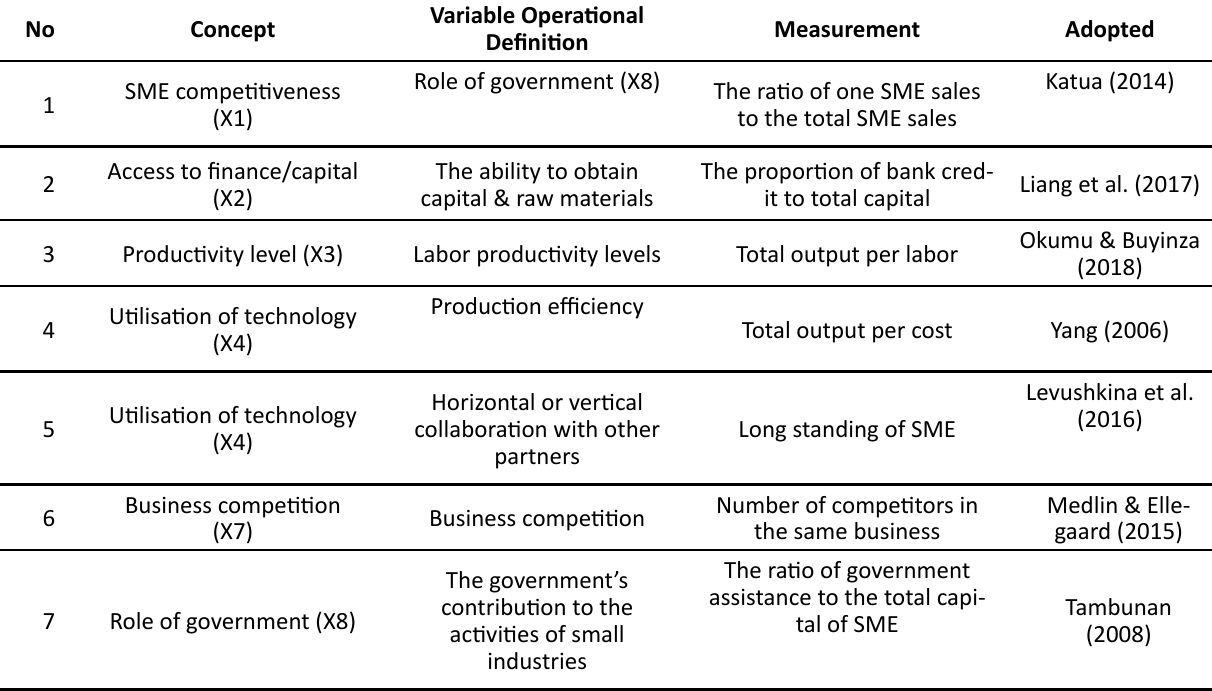
Table 1: Concept, Operational Definition and